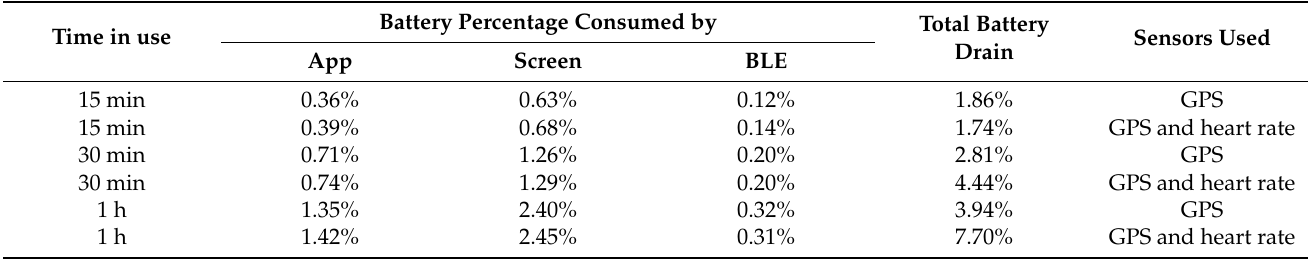
Table 1. Battery